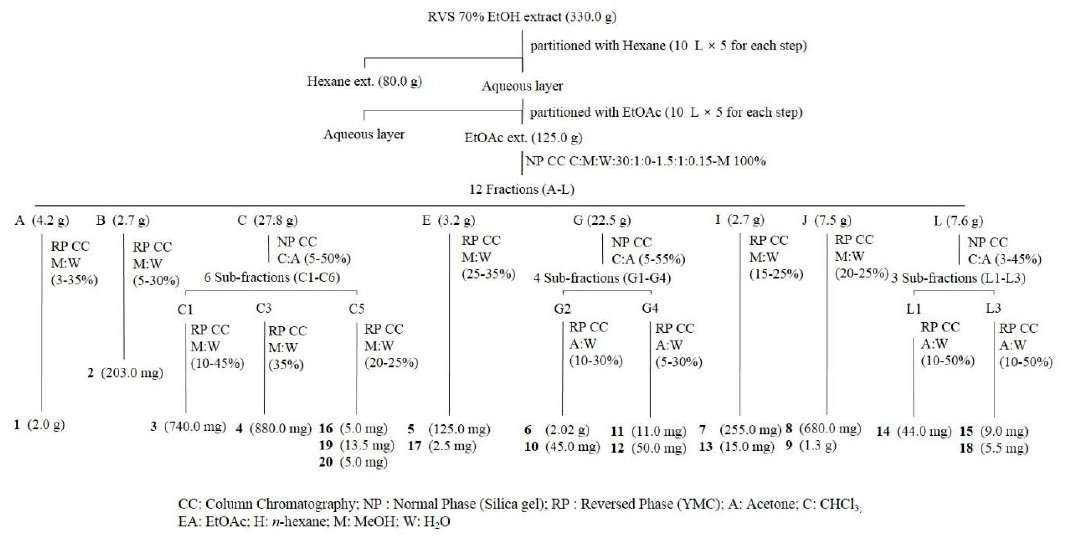
Figure 2. Isolation scheme of compounds 1 – 20 from Rhus verniciflua Stokes (RVS).